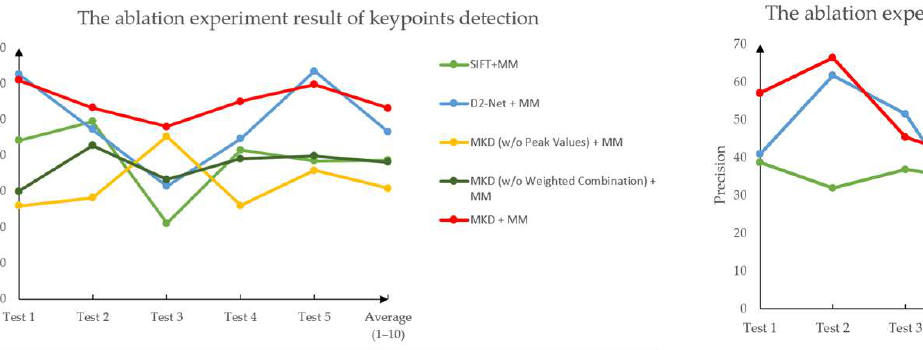
Figure 13. Ablation experiment results.